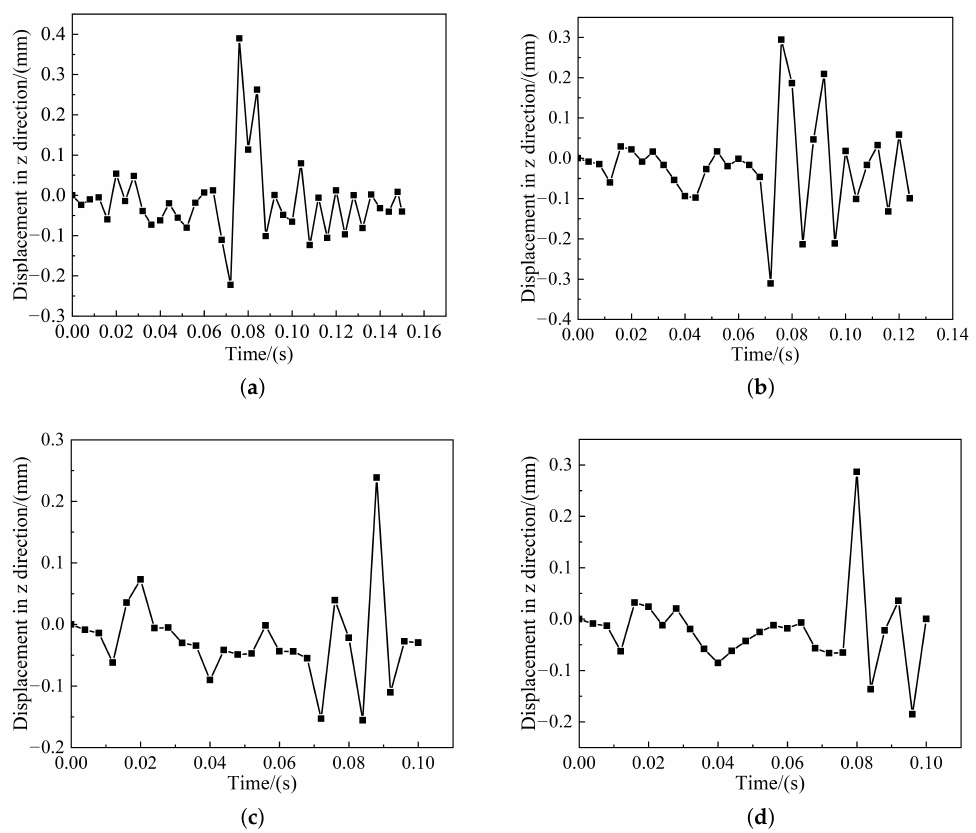
Figure 24. First round to lift volume change curve: ( a ) Pig head-on collision; ( b ) Pig offset collision; ( c ) Cow head-on collision; ( d ) Cow offset